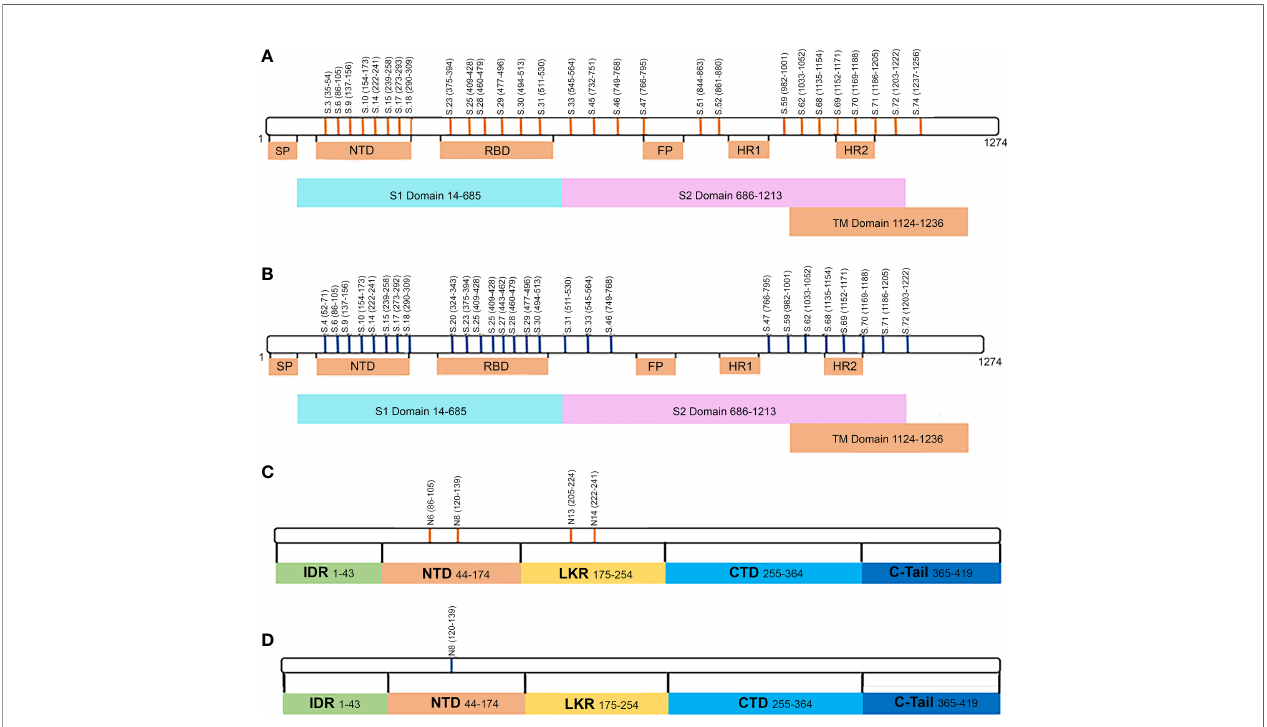
FIGURE 5 | Schematic presentation of S and N protein peptide locations that are reactive with fatal and non-fatal COVID-19 sera. (A) Location of S protein peptides reacting with IgG serum from early convalescent COVID-19; (B) Location of N protein peptides reacting with IgG serum from early convalescent COVID-19; (C) Location of S protein peptides reacting with IgG serum from late convalescent COVID-19; (D) Location of N protein peptides reacting with IgG serum from late convalescent COVID-19; Orange color – peptides reactive with early (1-2 months) convalescent COVID-19 IgG sera; Blue color – peptides reacting with late (10-12 months) convalescent COVID-19 IgG